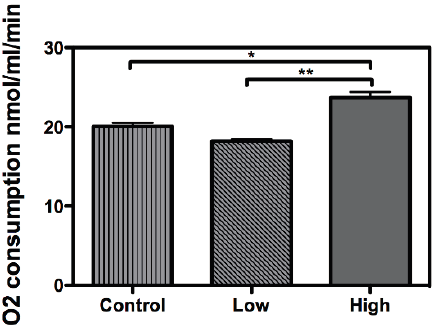
Figure 1. Transcriptional and activities of glycolytic enzymes are glucose concentration-dependent in BME26 cells. Transcriptional analysis of hexokinase ( A ); pyruvate kinase ( B ); HK activity ( C ) and pyruvate kinase activity ( D ), glycolytic key-enzymes, in embryonic Rhipicephalus microplus cells (BME26) in response to glucose treatment. Control: cells maintained with 50 mM of glucose; Low: cell maintained without glucose addition; and High: cells maintained with 100 mM of glucose. The experiment was performed with three independent biological samples in three experimental replicates each ( * p < 0.05; ** p < 0.001, ANOVA).